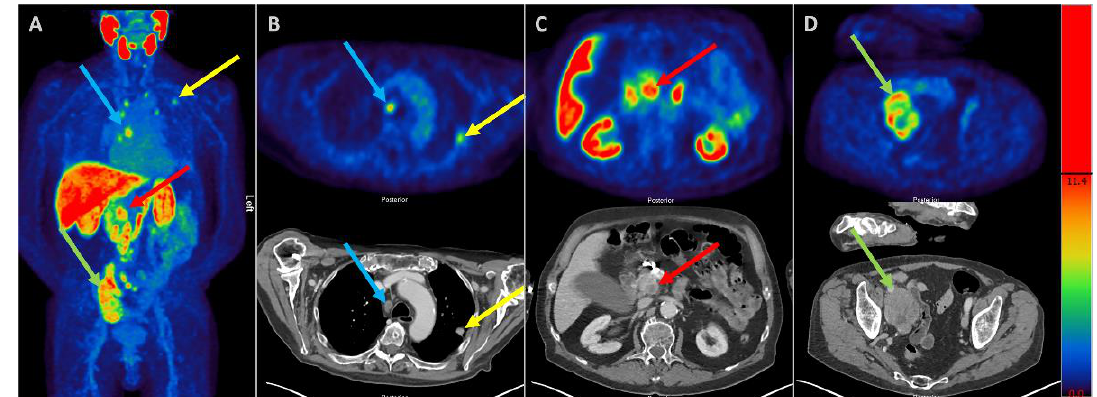
Figure 1. 18F-PSMA PET/CT scan of a patient with known prostate cancer (maximum intensity projection ( A )). Multilocular PSMA positive tumor lesions were revealed in the lung ( B ), the mediastinal ( B ), the pancreas ( C ) as well as in abdominal/iliac lymph nodes ( D ).